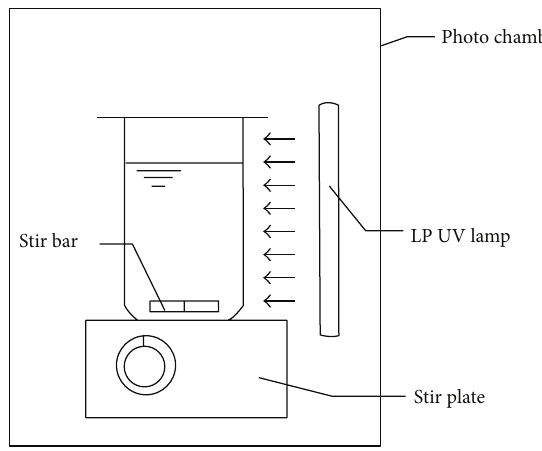
Figure 1: Illustration of experimental set-up (The 60 mL cylindrical quartz reactor has a diameter of 2.75 cm and a height of around 10.1cm. Up to three LPUV lamps in parallel was